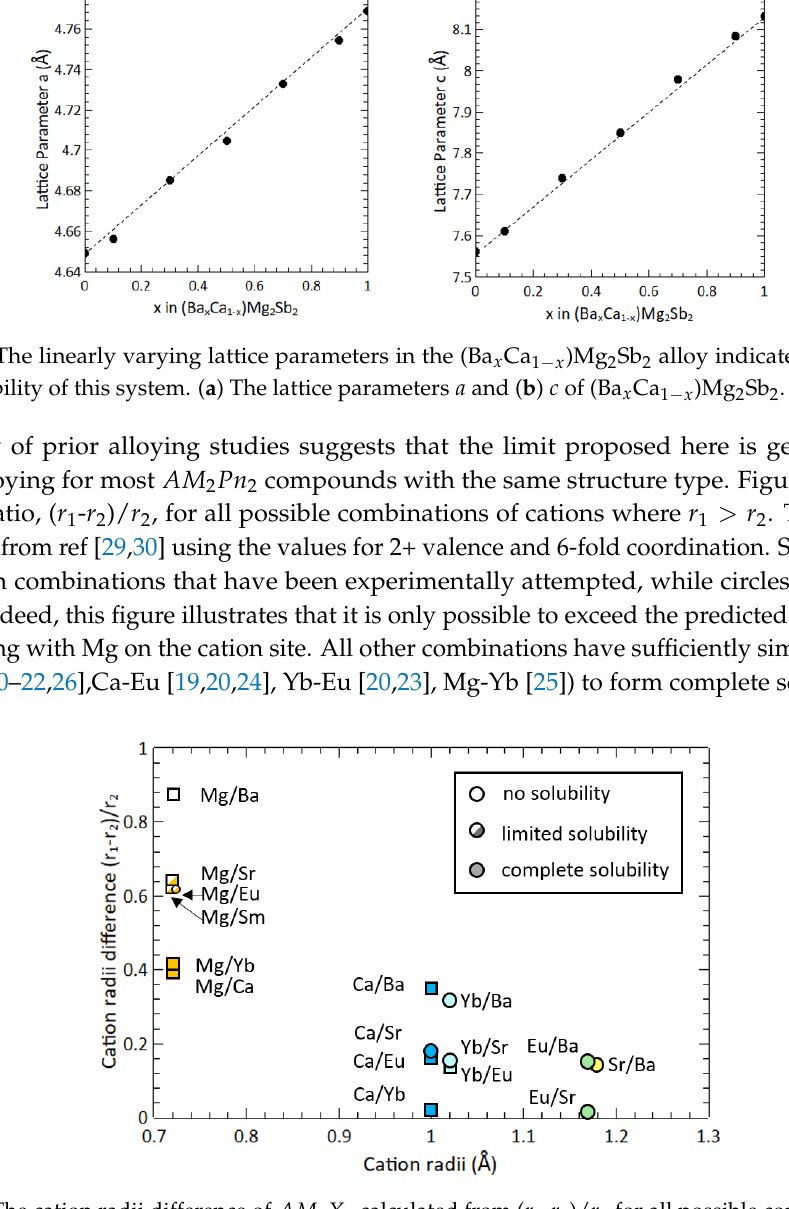
Figure 4. The cation radii difference of AM 2 X 2 calculated from ( r 1 - r 2 )/ r 2 for all possible combinations of cations where r 1 > r 2 . In each combination, the smaller species is listed first. Square symbols represent experimental observations, while circles represent predictions. The limited solubility in Sr/Mg (present study) and Sm/Mg (Reference [36]) alloys provide an approximate upper limit for cation radii mismatch. The complete solubility of Ca/Eu [19,20,24], Ca/Yb [20–22,26], and Yb/Eu [20,23] Mg/Yb [25] have been confirmed by prior